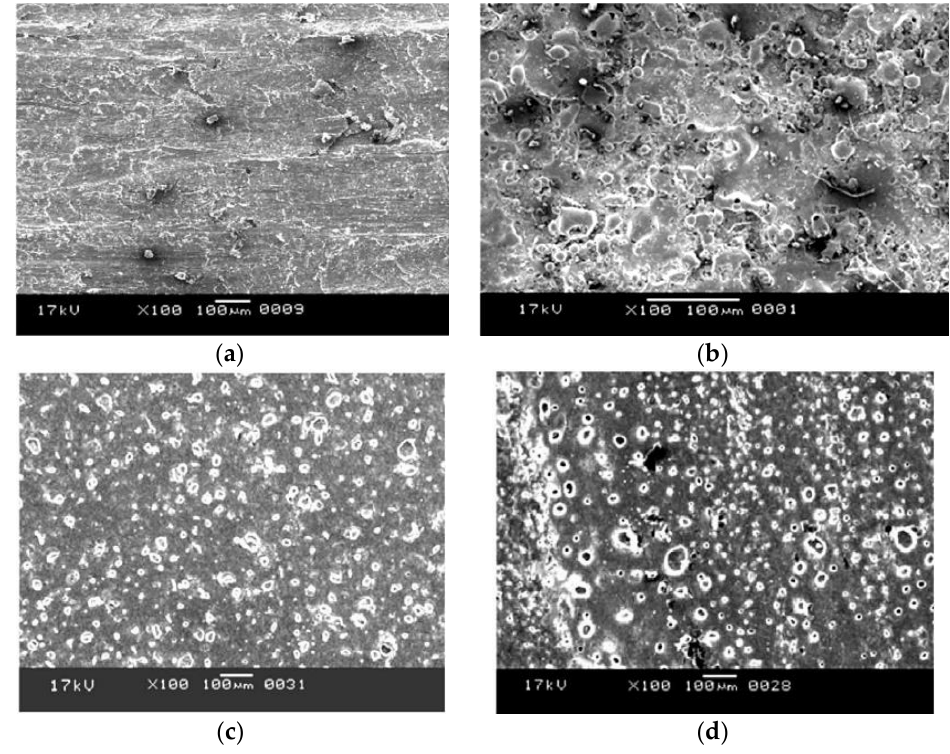
Figure 6. SEM images: ( a ) before machining; ( b ) after machining with initial parameters; ( c ) after machining with optimal parameters computed using BBO; and ( d ) after machining with optimal parameters computed using PSO. Table 9. Validation test for EDM through PSO.